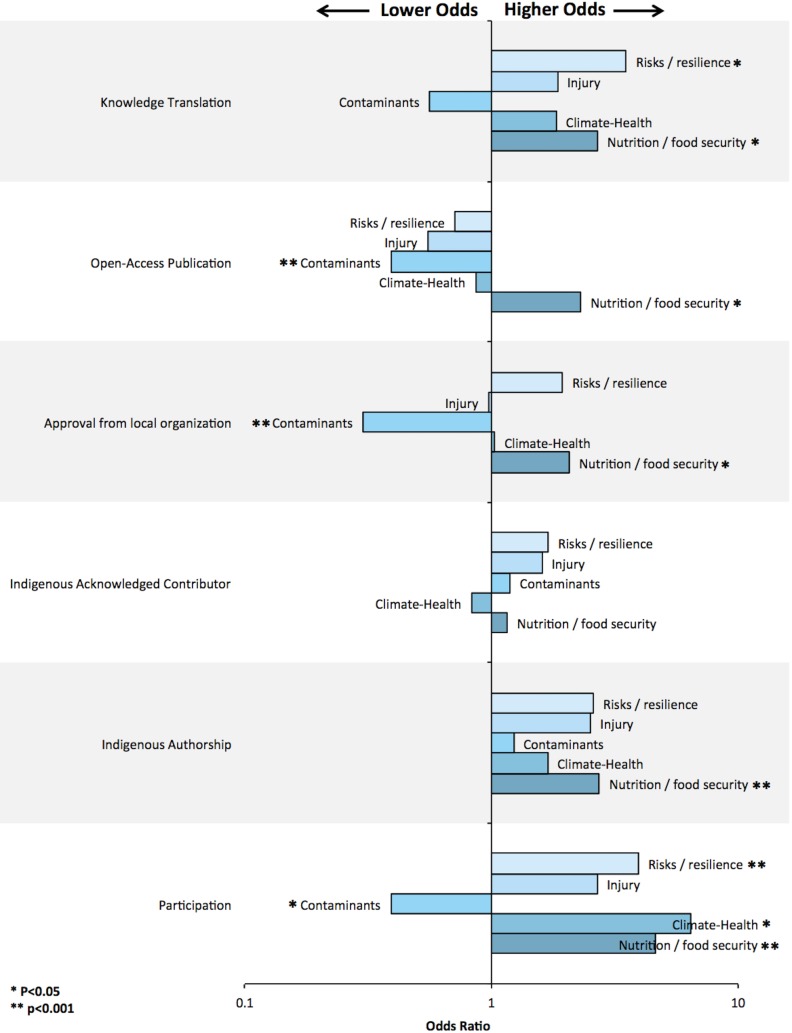
Multivariable exact logistic regression examining associations between research topic and various indicators of community-engaged research.